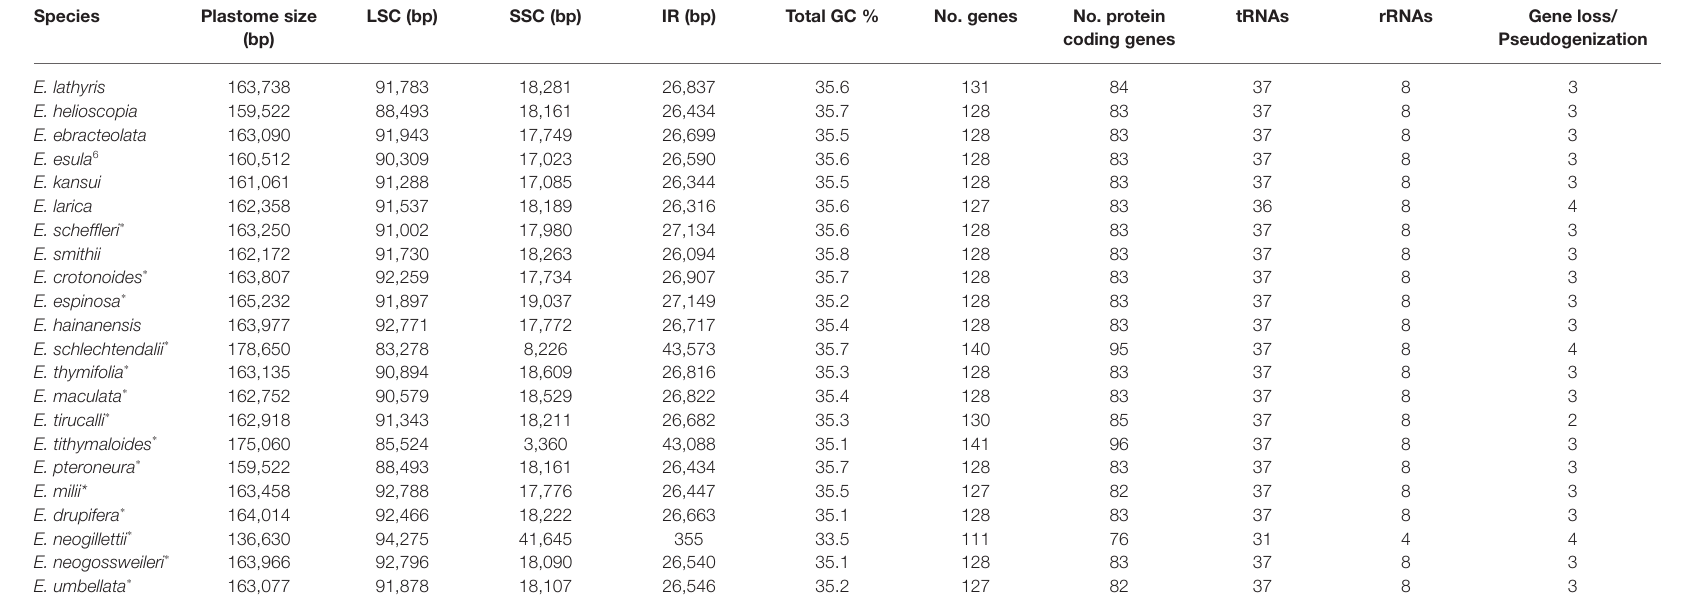
TABLE 1 | Summary of the 22 Euphorbia plastome assembled and annotated ( * indicates newly sequenced herein; - indicates the unavailable information). Species Plastome size